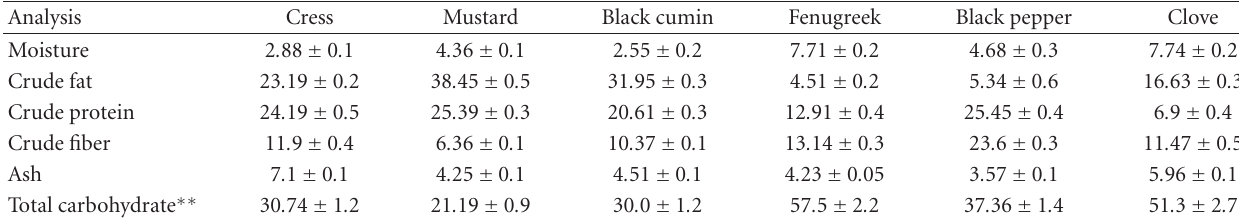
Table 1: Chemical composition (%) of cress, mustard, black cumin, fenugreek, black pepper, and clove seeds ∗ . Analysis Cress